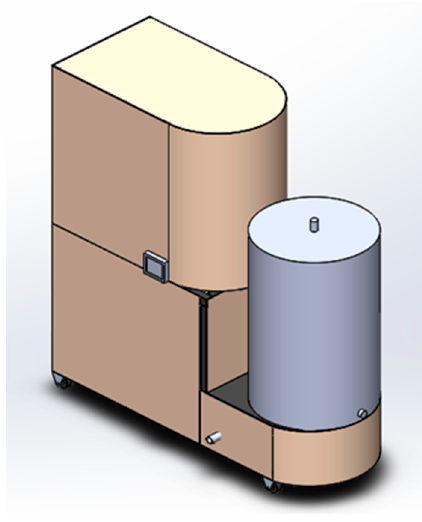
Figure 1. Water supply system concept.